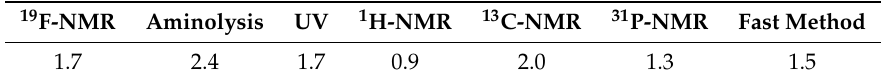
Table 6. Comparison of phenolic hydroxyl groups (mmol / g) for Organosolv lignin using 19 F-NMR and other techniques